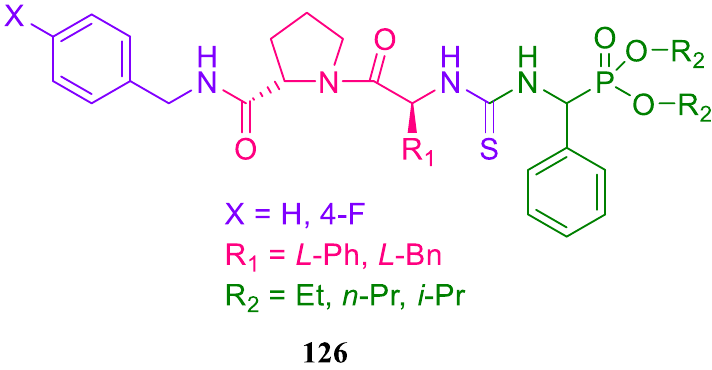
Figure 103. Chiral dipeptide thioureas containing α -amino phosphate analogues.